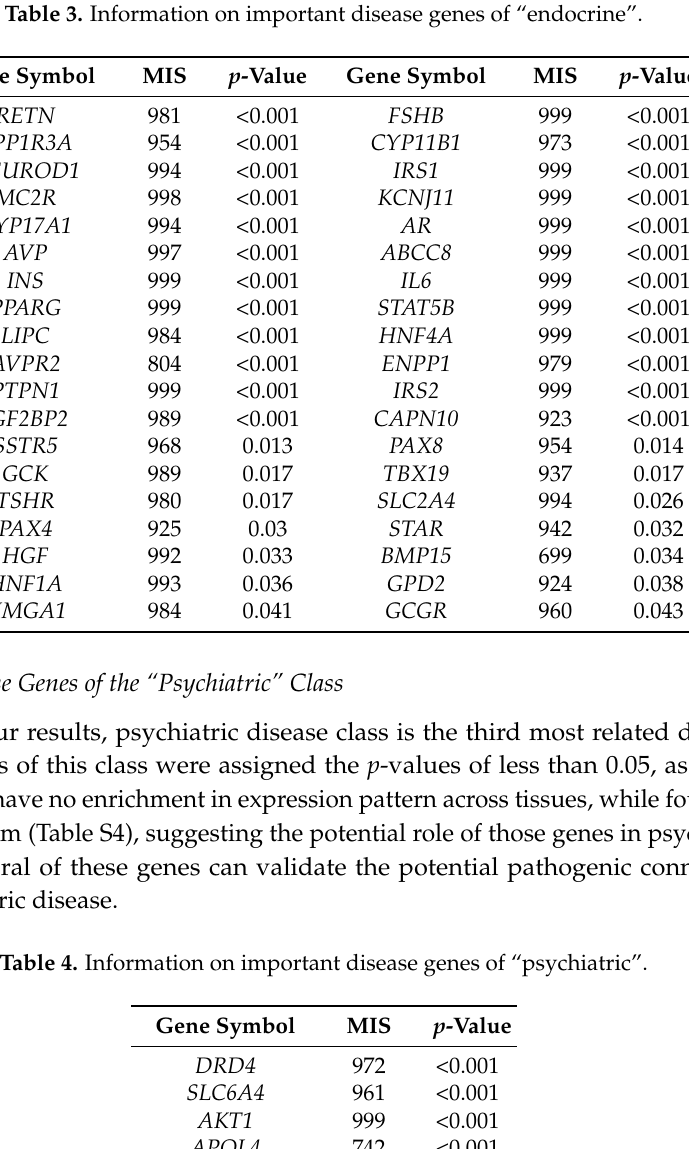
Table 3. Information on important disease genes of “endocrine”.